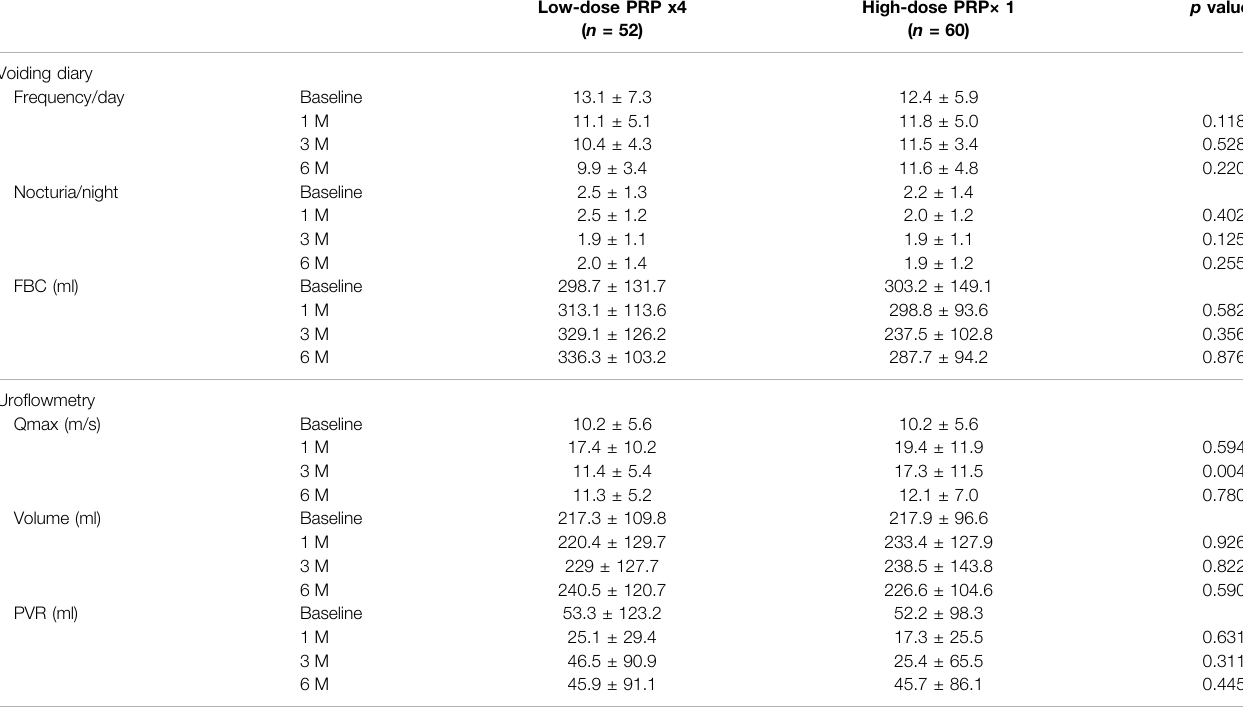
TABLE 5 | Changes in voiding diary and uro fl owmetry parameters among treatment groups from baseline to end-points.